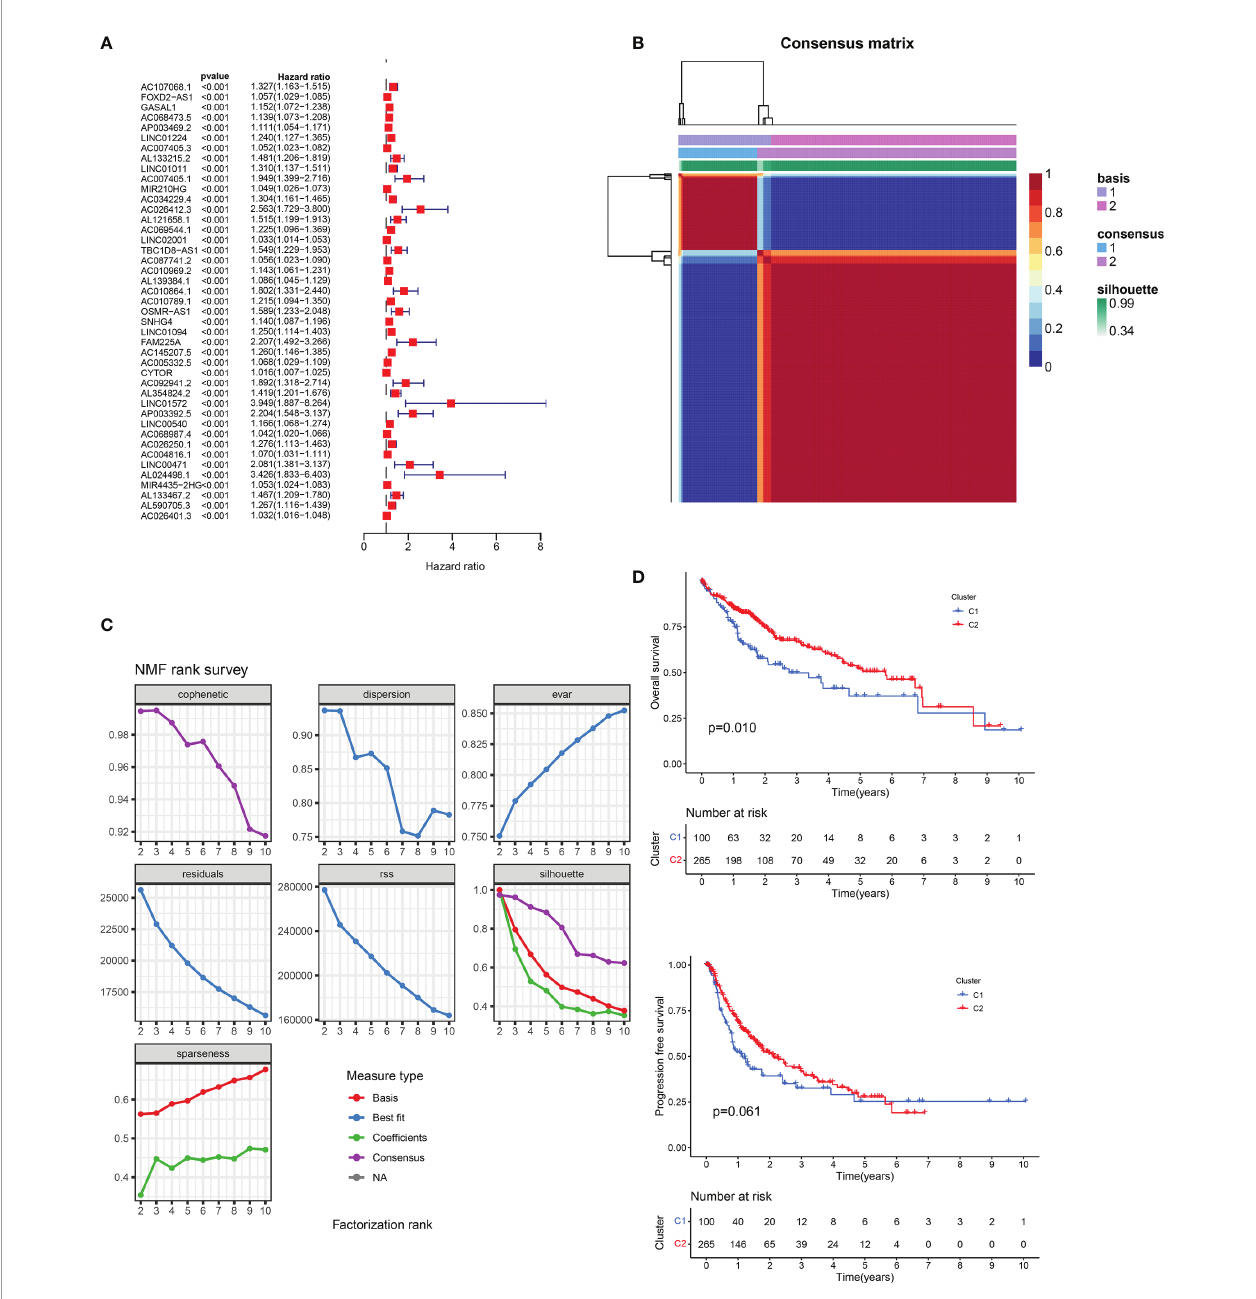
FIGURE 2 | (A) Univariate Cox regression analysis of prognostic m5C-related lncRNAs. (B) Consensus map of non-negative matrix factorization clustering. (C) Consensus clustering parameter. (D) Overall survival and disease-free survival prognostic survival curves of two molecular subtypes. NA, Not